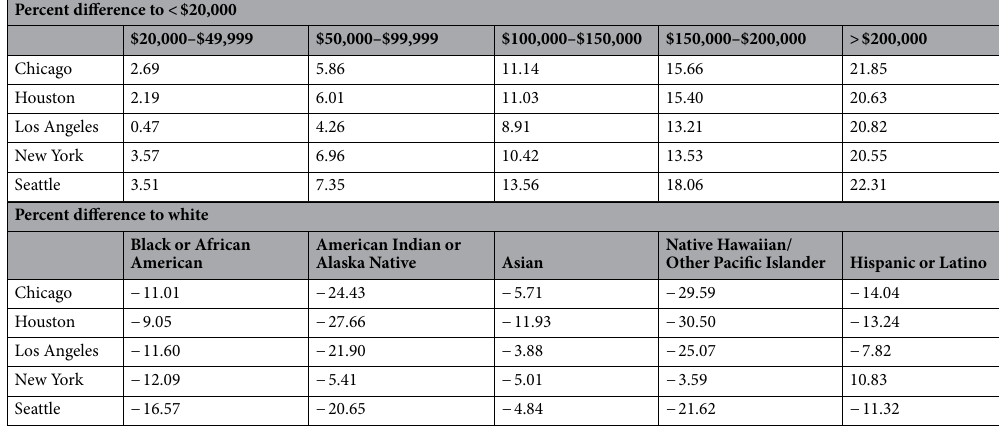
Table 1. Percent difference of in degree values for March 30th to April 5th. The percent difference of the in-degree values were calculated between the different income groups and racial-ethnic groups. In-degree values indicates the inflow measure of trips to the ZIP codes. This table shows an example of the different income groups comparing to the lowest income group (< $20,000) and an example to the different racial-ethnic groups to the white population. All the values can be found in Supplementary Information